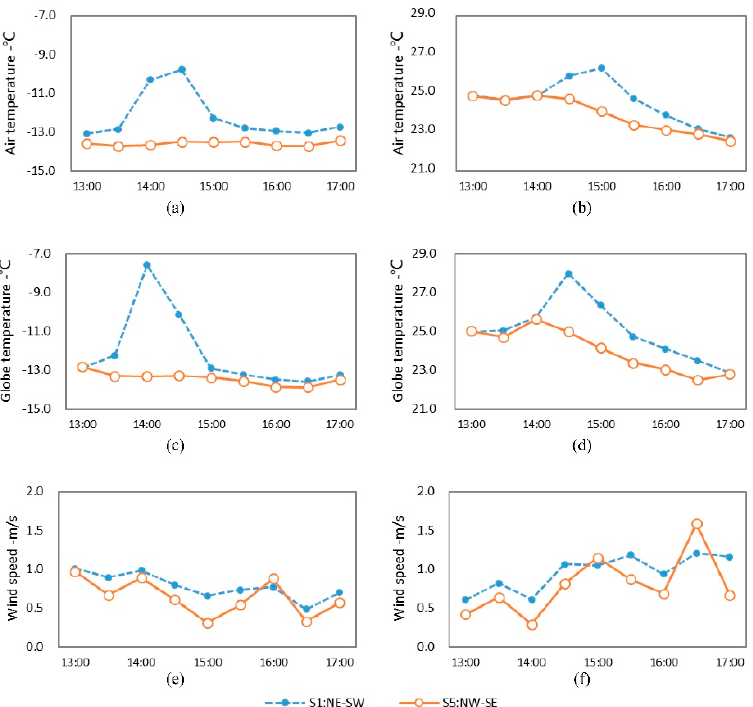
Figure 3. Variation of microclimate parameters of streets with different orientations. ( a ) T a in winter; ( b ) T a in summer; ( c ) T g in winter; ( d ) T g in summer; ( e ) wind speed in winter; ( f ) wind speed in summer.